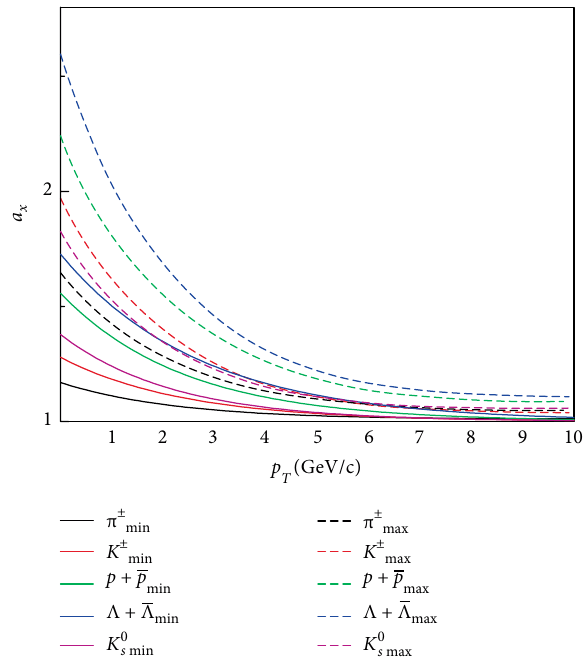
Figure 6: Transverse momentum dependency on the deformation of 𝜋 ± , 𝐾 ± , 푝 + 푝 , , and 𝐾 0 . The curves are the parameter 𝑎 Λ + Λ 𝑥 푠 results of this fitted based on Equation (11).